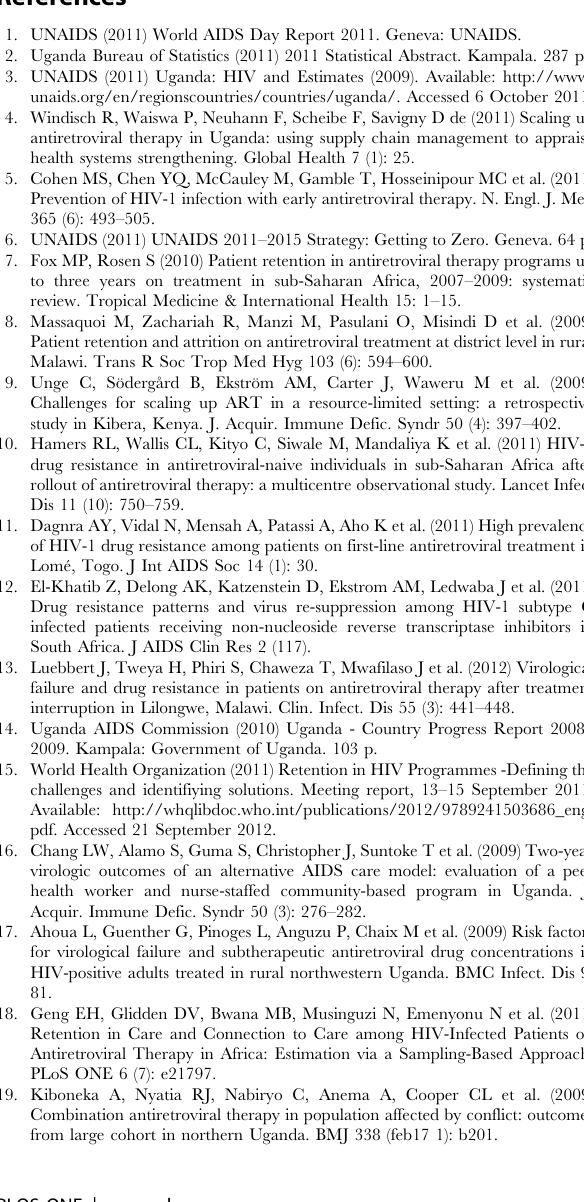
Table S1 Iganga District HIV projections for